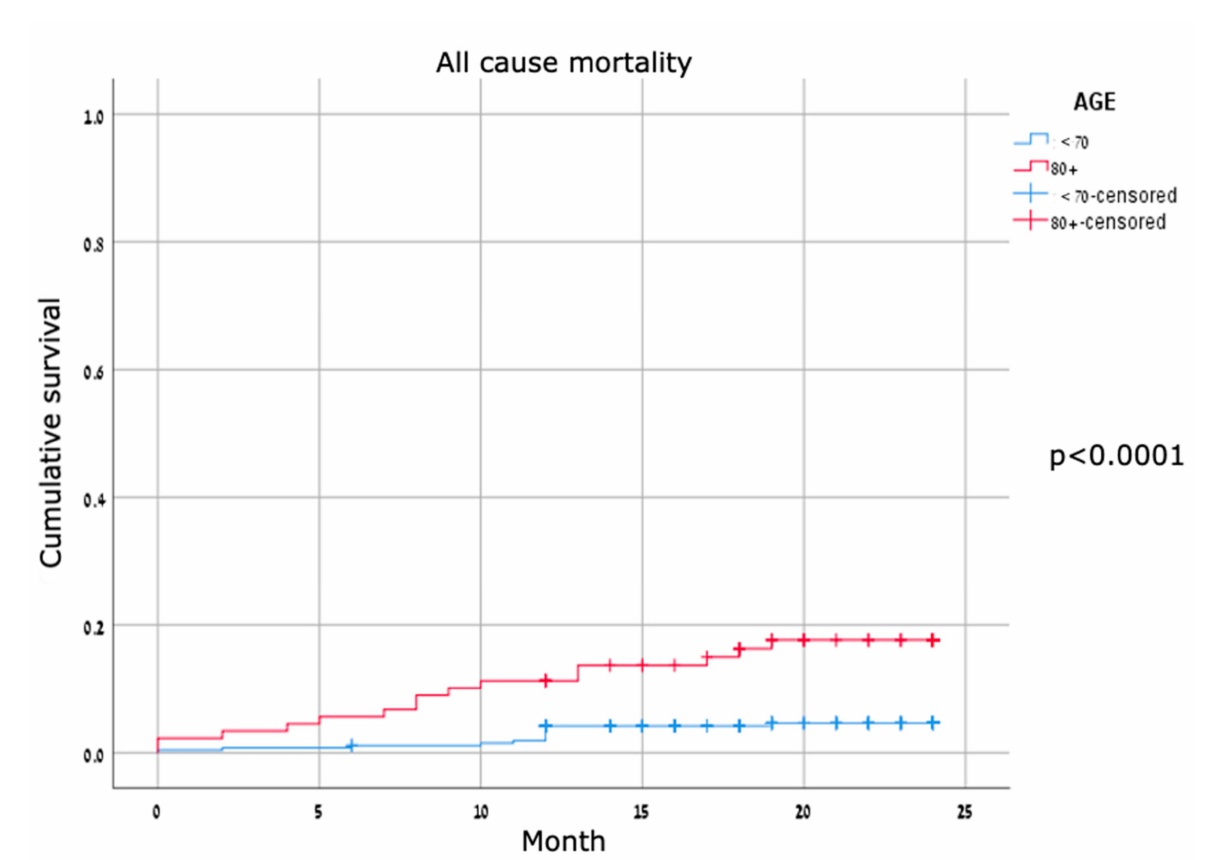
Figure 2. Kaplan–Meier curves for all-cause